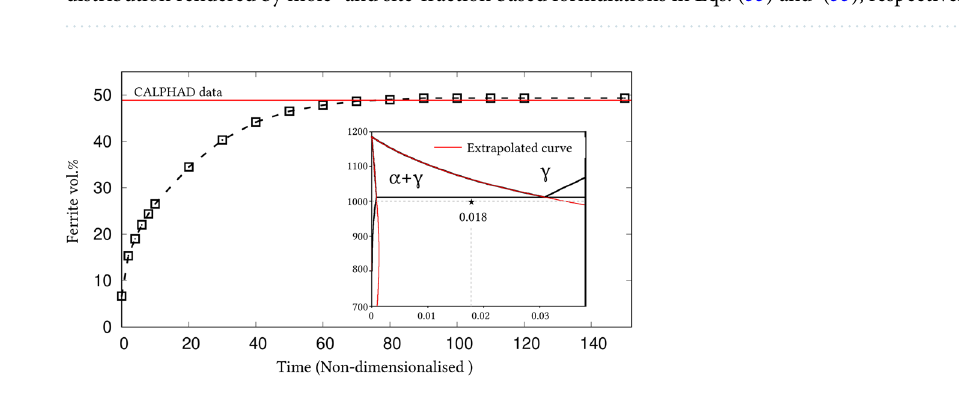
Figure 3. Cumulative influence of surface concentration, and spatial position, on the disparity in the carbon distribution rendered by mole- and site-fraction based formulations in Eqs. (53) and (55), respectively.